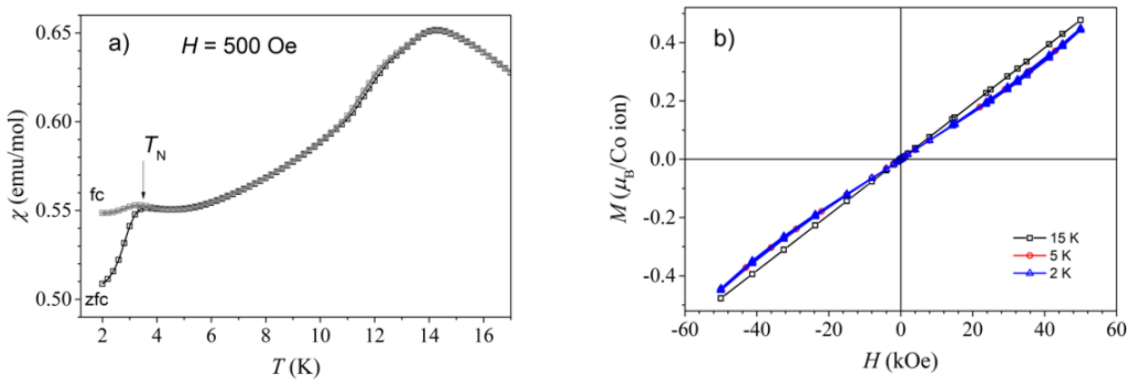
Figure 5. Zfc and fc susceptibility in low temperature range ( a ) and isothermal magnetization curves ( b ). The magnetization curves M ( H ) were measured at several temperatures. In Figure 5b, the M ( H ) curves for three temperatures are shown. At a temperature of 15 K, slightly above the maximum of susceptibility, the M ( H ) is linear. The M ( H ) curves measured at 5 K and 2 K, the temperatures that are just above and below the T N at 3.4 K, coincide and their initial slope is smaller than for the M ( H ) at 15 K. The magnetization in a maximal magnetic field that can be achieved in our measuring system, i.e., 50 kOe, is approximately Brillouin function [39] for Co(II) ions of approximately 3 µ B /Co ion. The M ( H ) curves magnetic ground state. In an external magnetic field of 30 kOe the slope of M ( H )